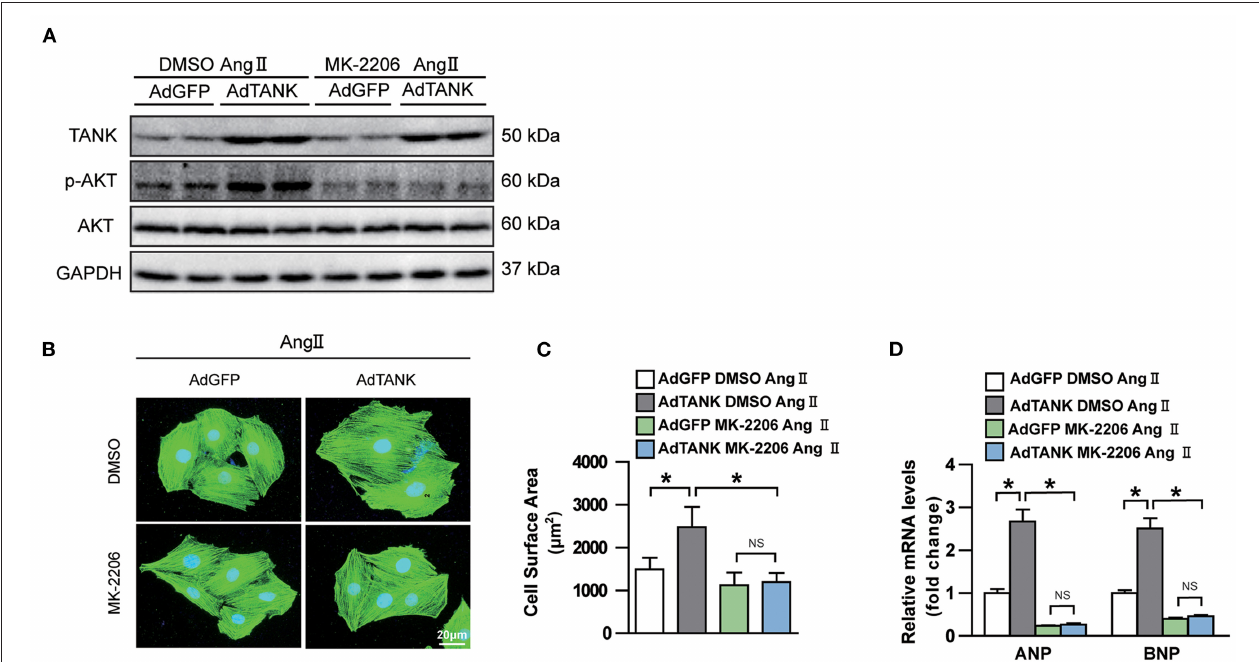
FIGURE 8 | Effect of AKT inhibitor MK-2206 on AngII-induced cardiomyocyte hypertrophy in TANK overexpression NRCMs. (A) Western blot showing MK-2206 inhibits phosphorylation of AKT after stimulation of AngII. (B) NRCMs infected with the indicated adenoviruses are incubated with MK-2206 or DMSO after stimulated with AngII. Sarcomere organization was stained using anti- α -actinin antibodies (green), and nuclei were determined by DAPI staining (blue). scale bar, 20 µ m. (C) Quantification of cell surface area of indicated groups after MK-2206 or DMSO treatment ( n > 50 cells per experimental group). (D) mRNA level of hypertrophic marker ANP and BNP in TANK overexpression cell and control group treated with MK-2206 or DMSO after stimulated with AngII ( n = 3 independent experiments). * P <